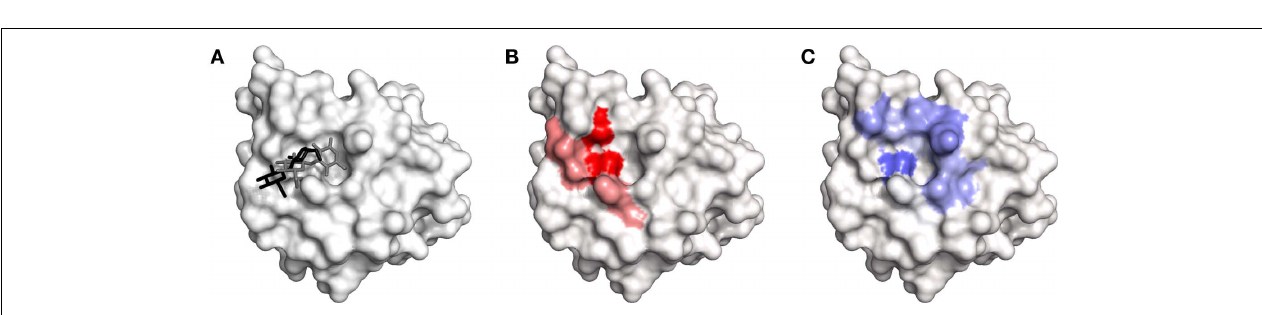
FIGURE 7 |The recognition of Glc β (1 → 3)Glc by langerin. (A) Comparison of crystal structure binding mode of Glc β (1 → 3)Glc (PDB code 3P5H; black)